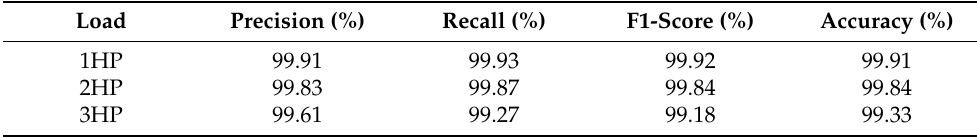
Figure 20. The confusion matrix of IGVMD–1DCNN. Table 6. The diagnosis result evaluation of different functioning mode.